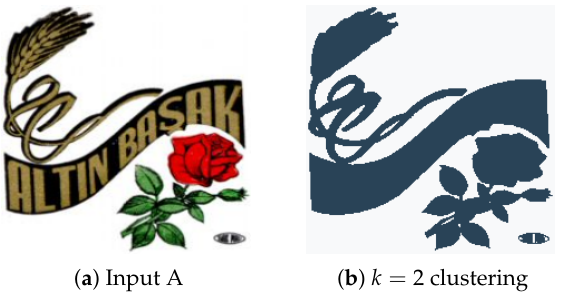
Figure 8. ( a ) Experiment A input; ( b ) Experiment A K-Means clustering ( k = 2).